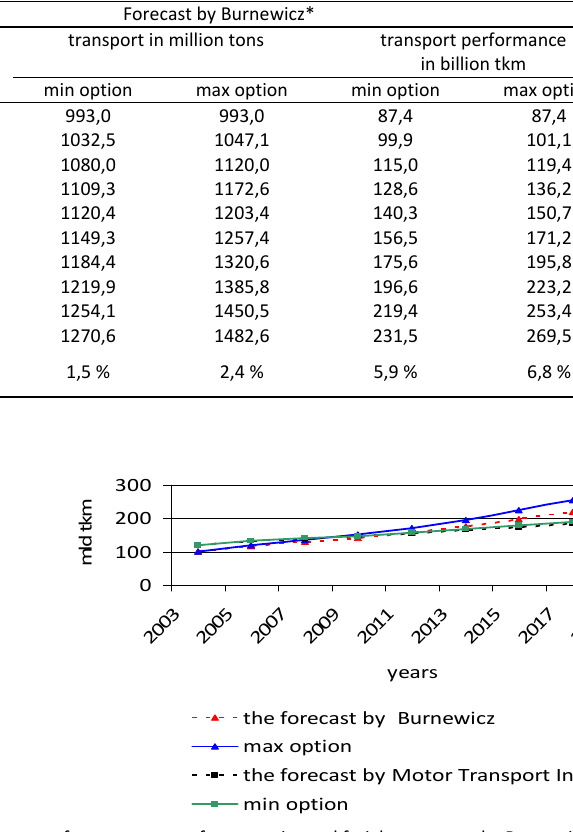
Fig. 3: The forecasts for transport performance in road freight transport by Burnewicz and Motor Transport Institute. (*Burnewicz, 2005; **MTI, 2018)